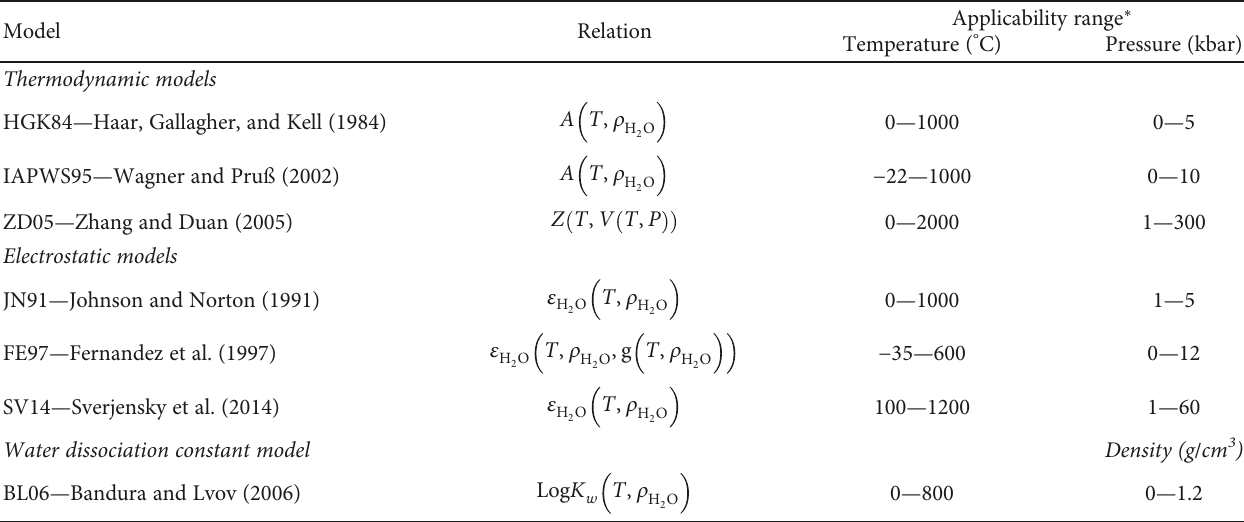
Table 1: The water thermodynamic and electrostatic models investigated in this study and their recommended applicability range ( ∗ based on the temperature and pressure conditions of the experimental data used for the model parameterization and the estimated accuracy of the extrapolation beyond the conditions of the experiments evaluated by the authors of the model). Water dissociation constant model used for